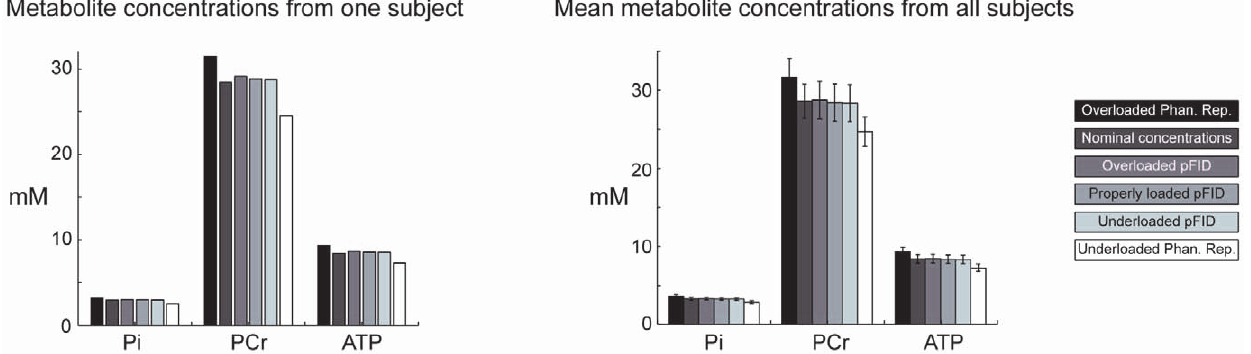
Figure 4. Typical metabolite concentrations from one subject and the mean ( + / 2 standard deviation) metabolite concentrations from all subjects. The pFID method provided accurate estimates of metabolite content in each subject that were in agreement with the nominal concentrations. The pattern was consistent for all subjects, as reflected by the bar graph of the mean concentrations. The standard deviations primarily reflect the true range of concentrations within the subjects (as seen in Figure 3) rather than random variations in the measurements.